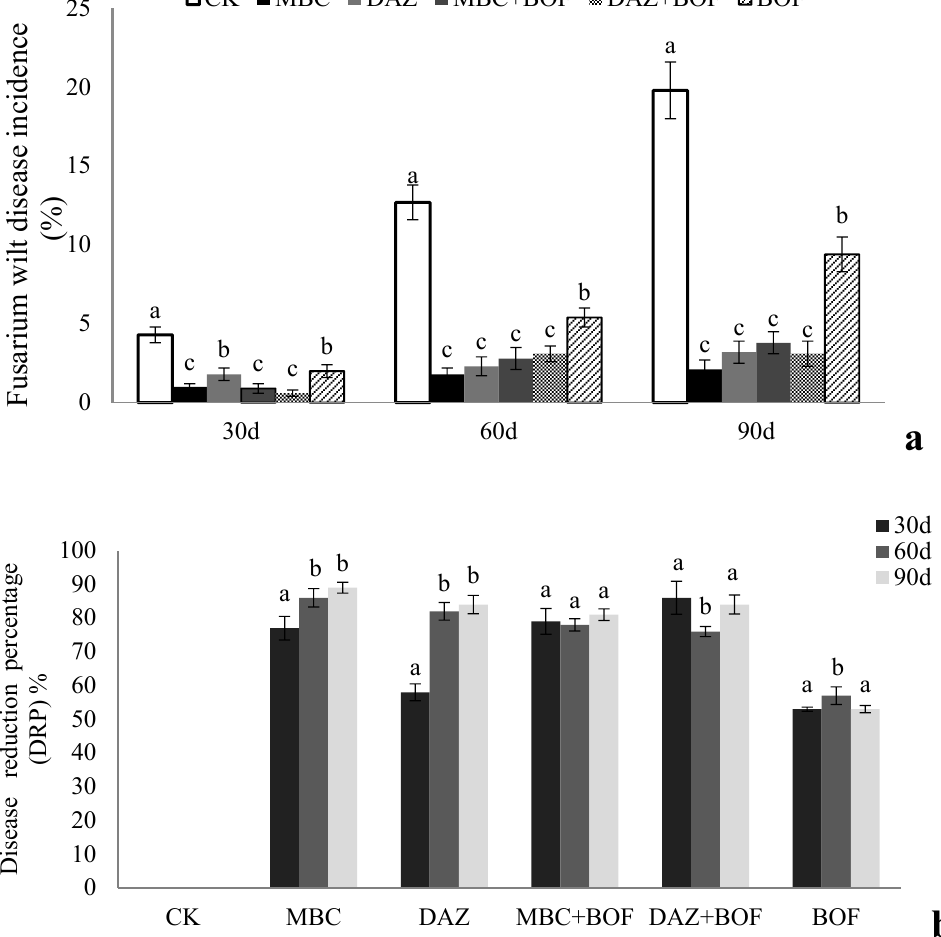
Figure 1. Chrysanthemum Fusarium wilt incidence ( a ) and disease reduction percentage (DRP) ( b ) as affected by exposure to the various treatments for between 30 to 90 days following transplantation after three croppings. The bars represent the mean and the whiskers the standard deviation. See footnote to Table 1 for the treatment codes. Letters above the bars indicate a significant difference according to Duncan’s multiple range test at p < 0.05 level.